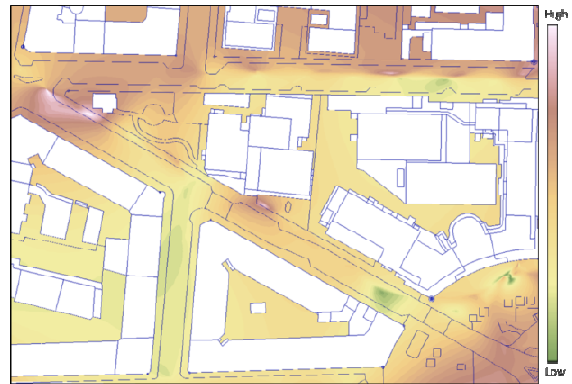
Figure 10. Generation of the map of the presence of particulate (PM 2.5) in the study area, deriving from the interpolation of the measured values conducted on the GIS platform.